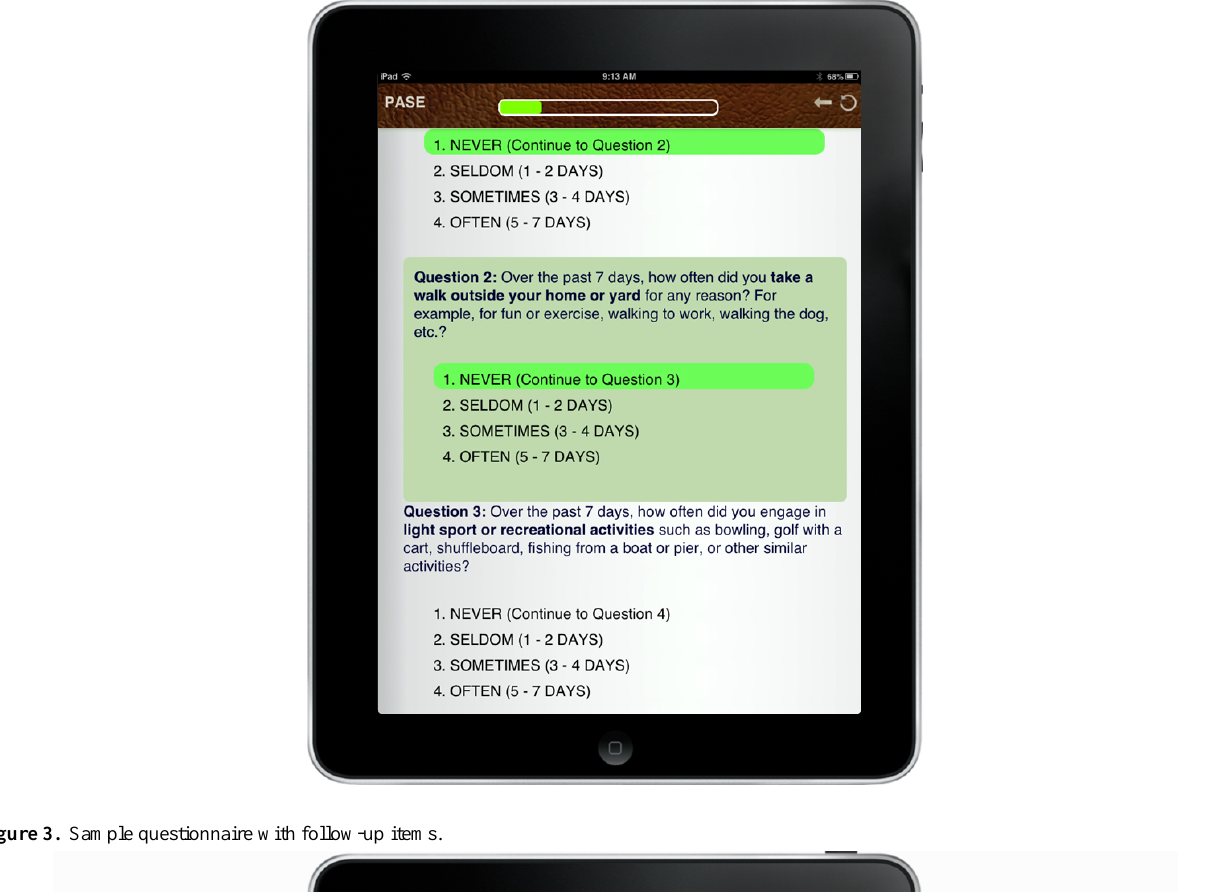
Figure 2. Sample questionnaire without follow-up items.